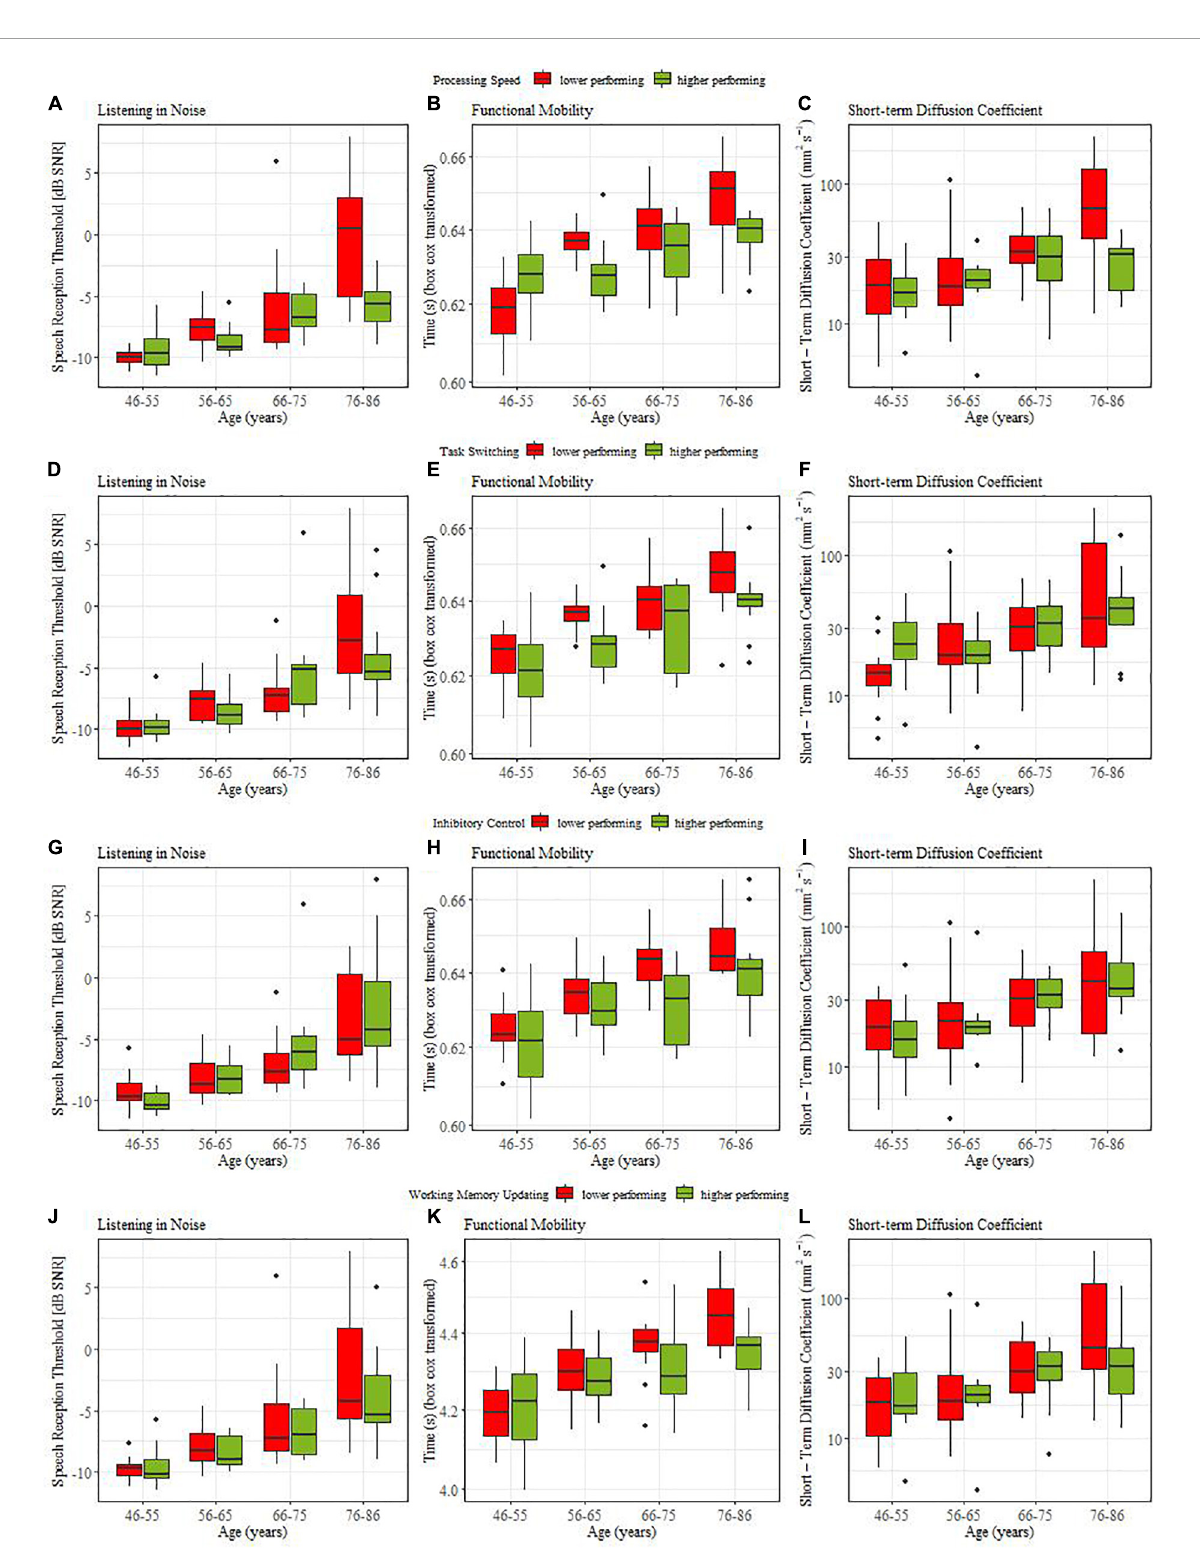
FIGURE3 Coupling between sensorimotor and cognitive functions for lower (red) and higher (green) performing participants.